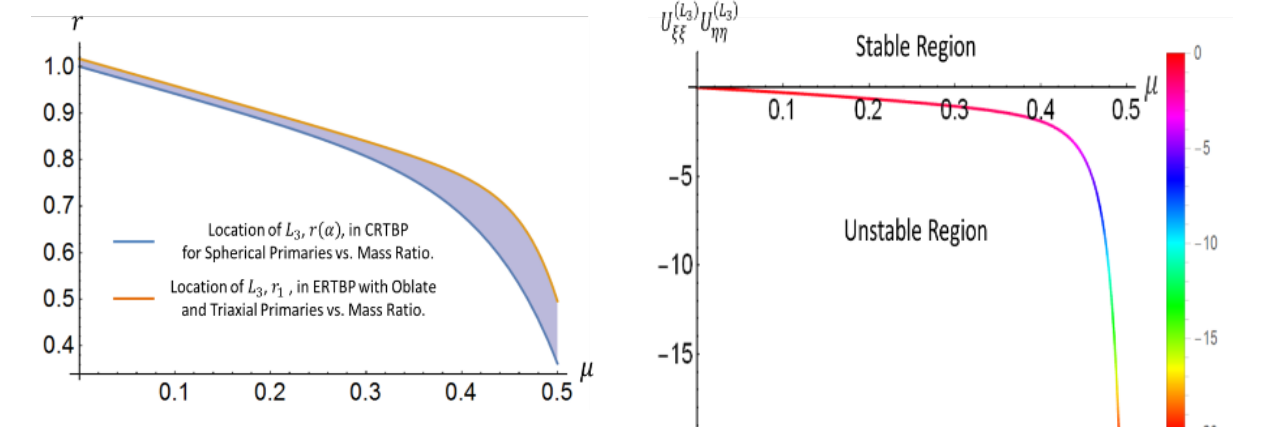
Figure 7. Location of L 3 vs. µ for two different cases, CRTBP for spherical primaries and ERTBP with oblate and triaxial primaries